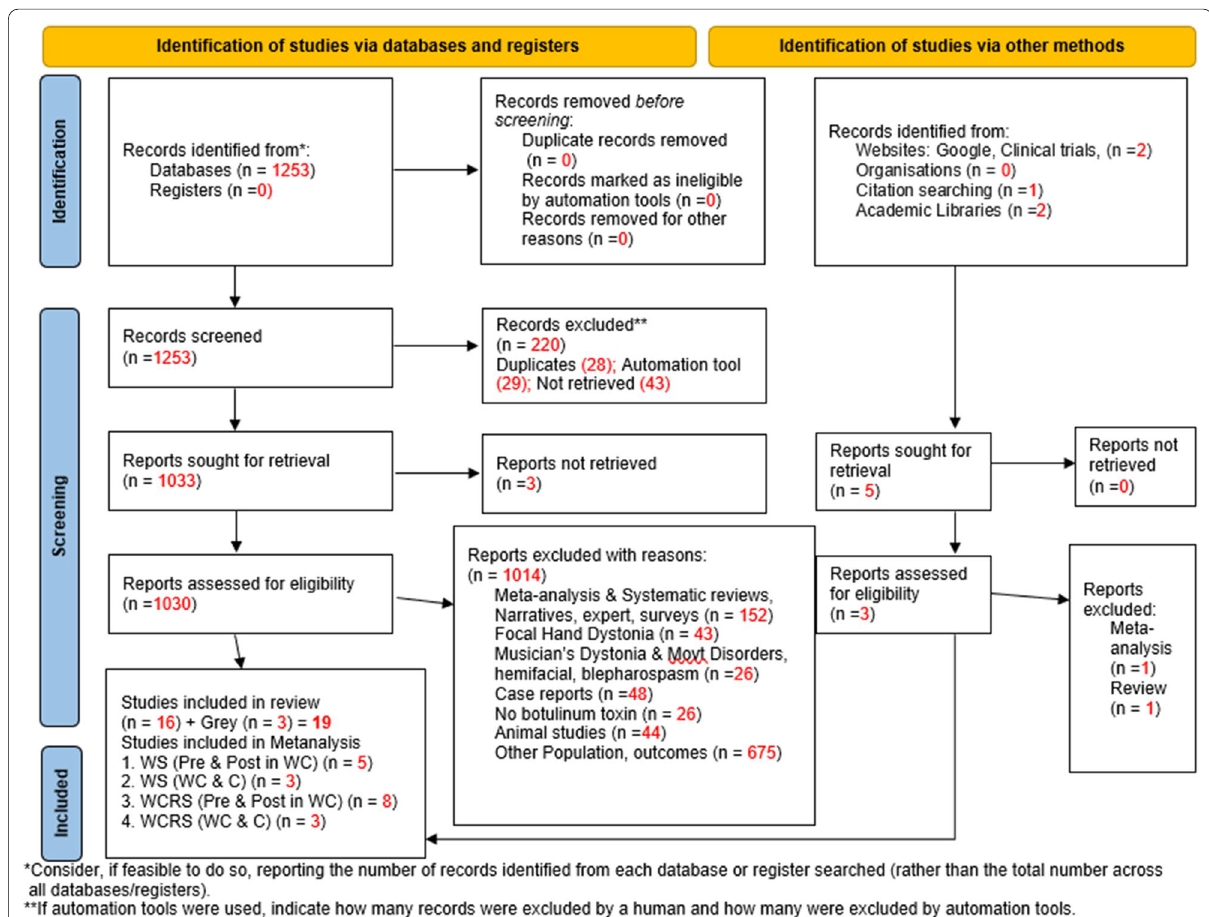
Fig. 1 PRISMA 2020 flowchart for including studies in the systematic